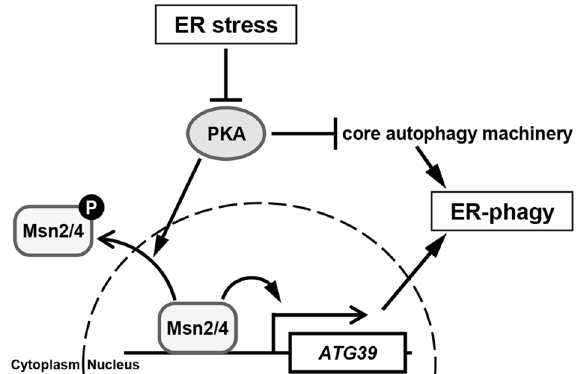
Figure 6. Proposed model for Msn2/4 in ER stress-induced